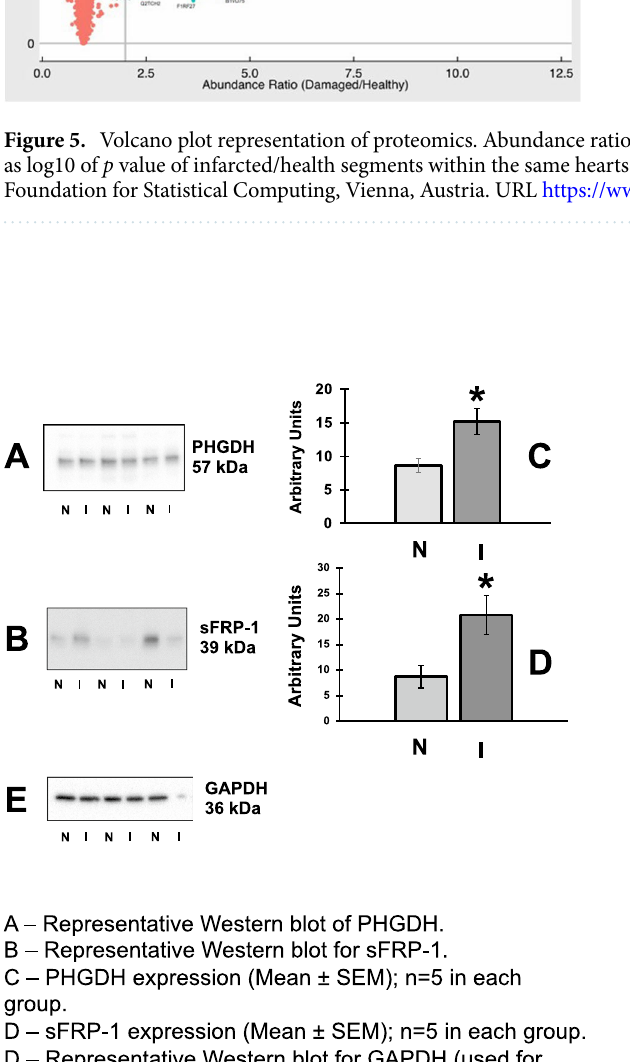
Figure 6. Quantification of D-3PGDH and sFRP1 proteins by western blotting. All data presented as Mean ± SEM; n = 5 in each group. Quantification of D-3-phosphoglycerate dehydrogenase (D-3PGDH) and secreted frizzled-related protein 1 (sFRP1) in lysates of the infarcted myocardium (I) and non-infarcted myocardium (N). ( A ) Representative western blot of D-3PGDH; ( B ) Densitometric quantification of D-3PGDH; ( C ) Representative western blot for sFRP1; ( D ) Densitometric quantification of sFRP1 expression; ( E ) Representative western blot for anti-glyceraldehyde 3-phosphate dehydrogenase (GAPDH, used for control of protein loading); * P < 0.05 versus non-ischaemic myocardium. MW: molecular weight. Statistical Test used: Mann–Whitney. (Figure S1 shows the full blots for the proteins shown in this